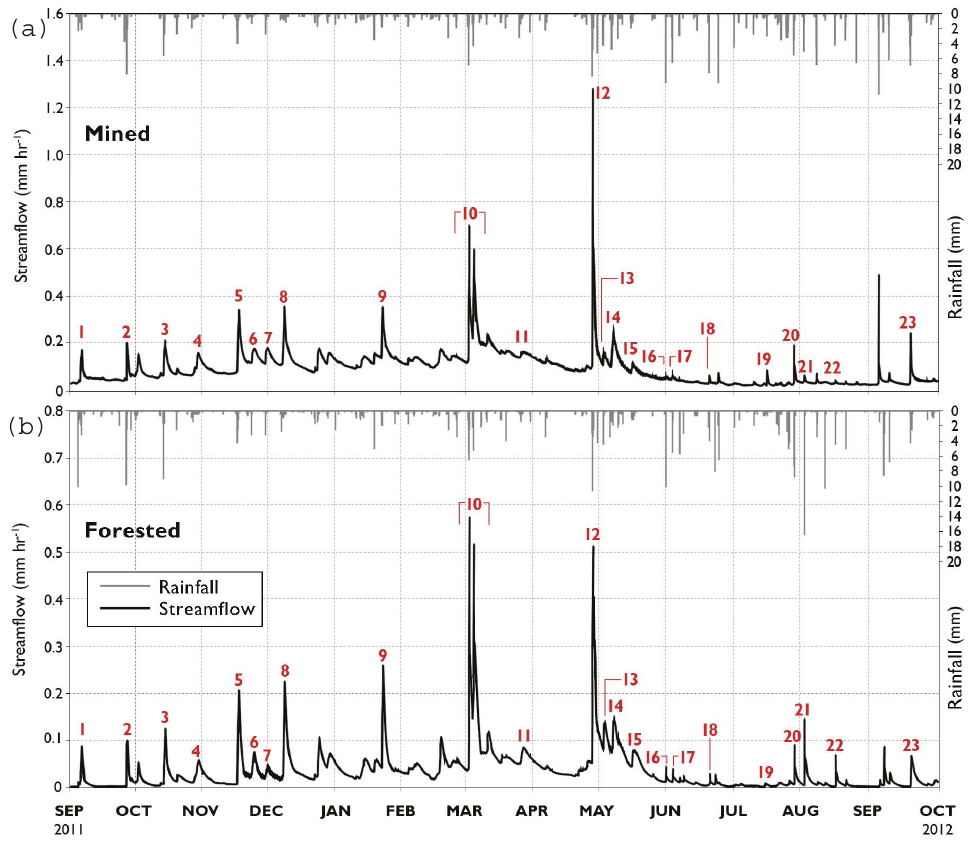
Figure 5. Storm event hydrographs and hyetographs for the ( a ) mined and ( b ) forested catchments for the study period from September 2011–October 2012. The storm events included in the analyses are noted sequentially. The large storm in the mined catchment in late September 2012 was excluded from analysis because the vent tube to compensate for atmospheric pressure was incorrectly assembled after exchanging